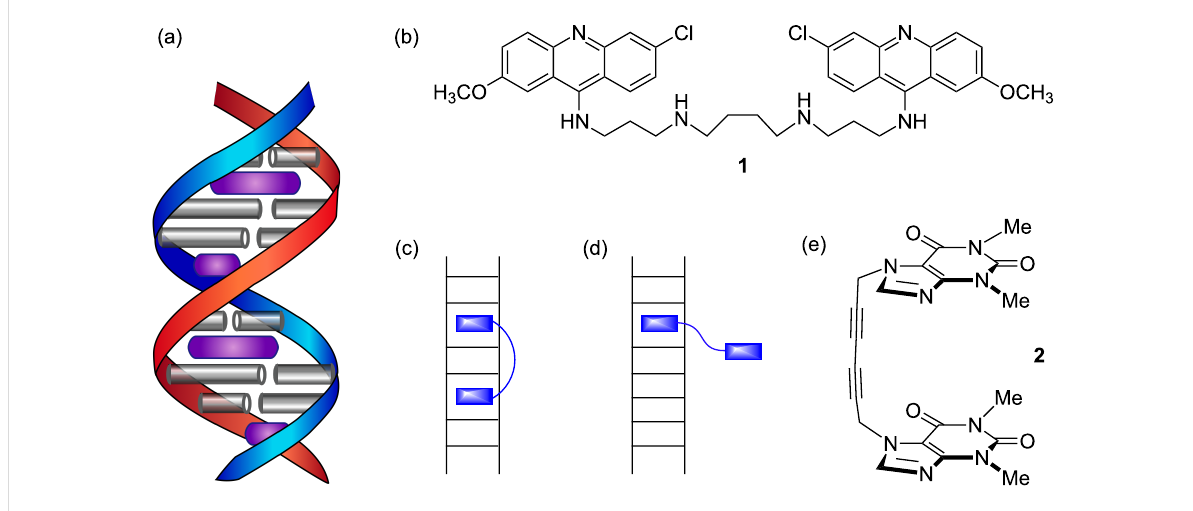
Figure 2: (a) Schematic double helix fully saturated with intercalator (in purple) according to the neighbor exclusion principle (NEP). (b) Bisinterca- lator with spermine linker. (c,d) Bisintercalator with long linker spanning two base-pairs and short linker preferring mono-intercalation to obey NEP. (e) Whitlock’s “rigid” molecular